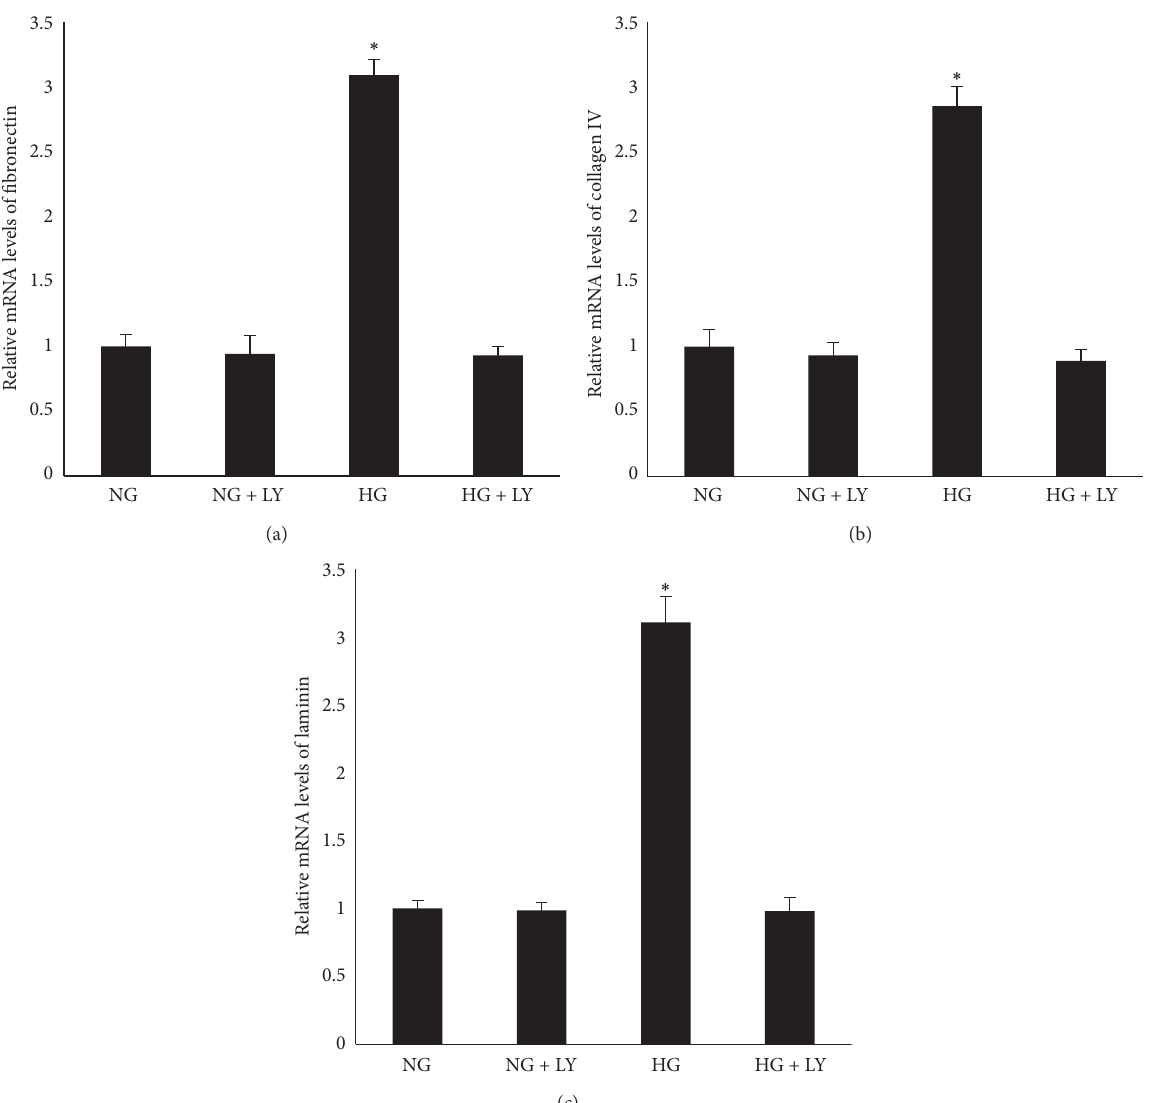
Figure 5: The PI3K/Akt signaling pathway mediated the mRNA expression of fibronectin, collagen IV, and laminin in RPE cells under high glucose conditions. (a, b, c) After pretreatment with 20 𝜇 M LY294002 for 12h, the mRNA expression of fibronectin, collagen IV, and laminin was significantly decreased when exposed to high glucose conditions for 24 h in RPE cells. ∗ 𝑃 < 0.01 versus NG or HG + LY. The data shown represent the mean ± SD of three independent